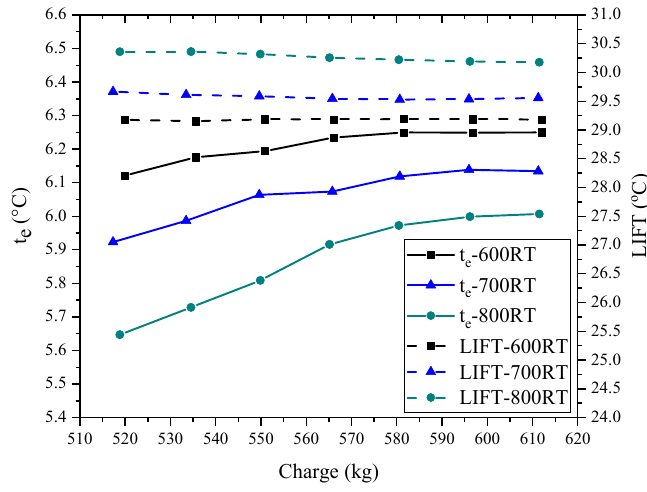
Figure 9. t e , LIFT as a function of charge at each cooling capacity. The influence of the variation of the cooling capacity, evaporation temperature and condensation temperature on COP can be considered by the calculation based on the compressor efficiency map, which is obtained at a certain suction superheat, so it can be considered that there is no liquid carryover effect. Therefore, the difference between the calculated and test COP can reflect the effect of the liquid entrainment factor. Figure 10 shows the efficiency factor contours of the test compressor, where Φ is the percent of the rated volumetric flow rate and Ψ is the percent of the rated polytropic work, as described by Equations (24) and (26), respectively.